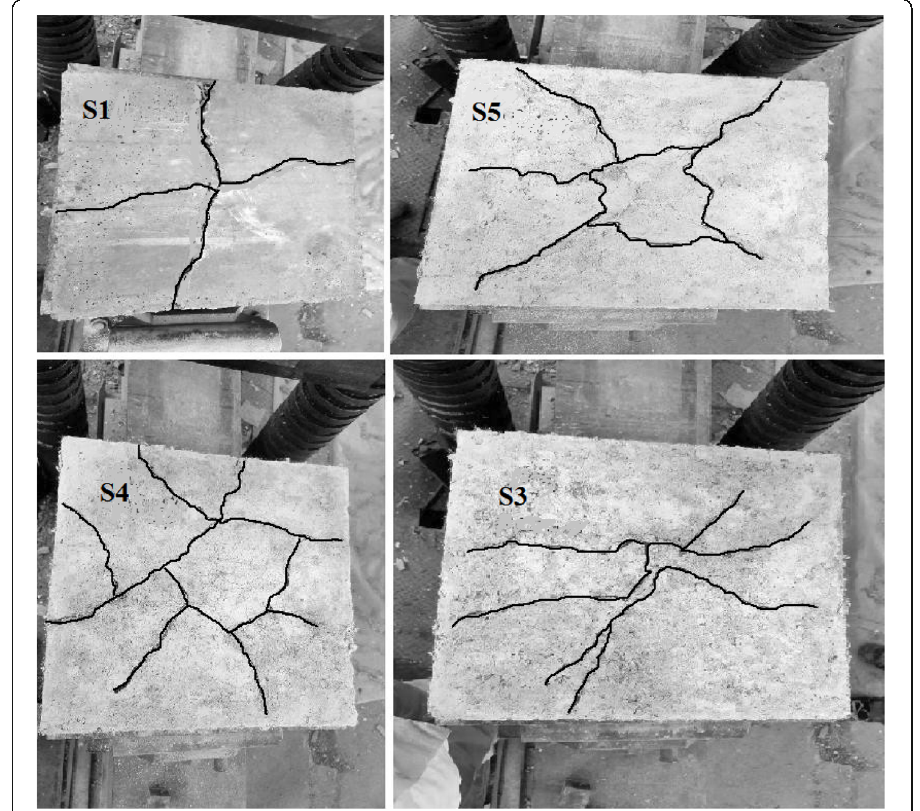
Fig. 4 Cracking patterns of different